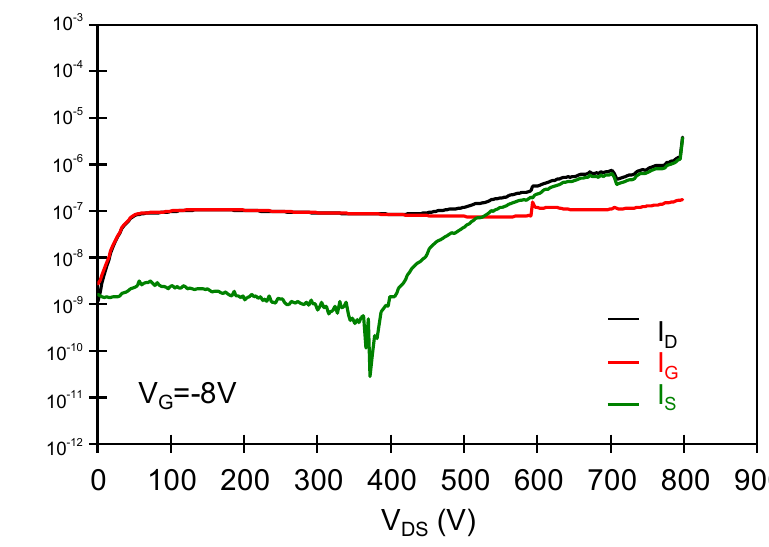
Figure 12. Breakdown test carried out on a transistor with p-GaN gate. With a negative gate bias (V GS = − 8 V), the drain bias is swept to 800 V, and the source, drain and gate currents ae measured.